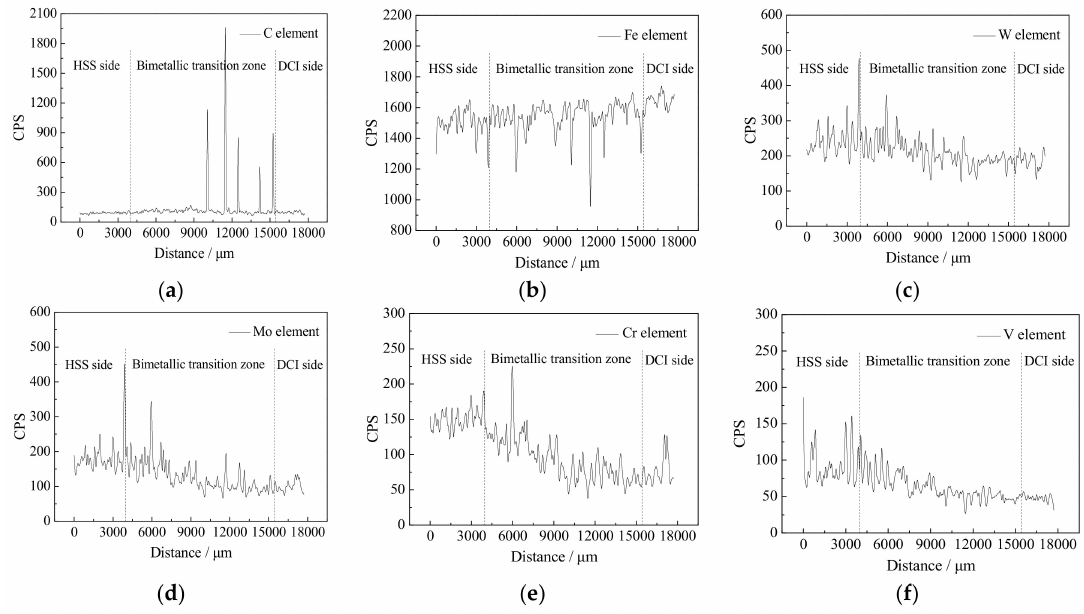
Figure 9. Elements distribution in the bimetallic bonding interface: ( a ) C element; ( b ) Fe element; ( c ) W element; ( d ) Mo element; ( e ) Cr element; and ( f ) V